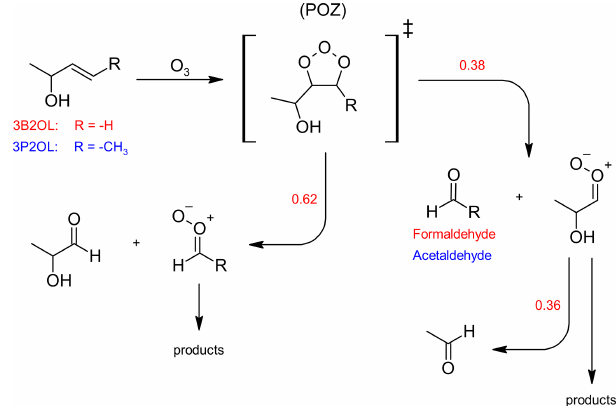
Figure 2. Formation of 2-hydroxypropanal through the ozonolysis of 3-buten-2-ol (3B2OL, red) and 3-penten-2-ol (3P2OL, blue) and respective average branching ratios. For readability reasons only one stereo-isomer is drawn for each Criegee